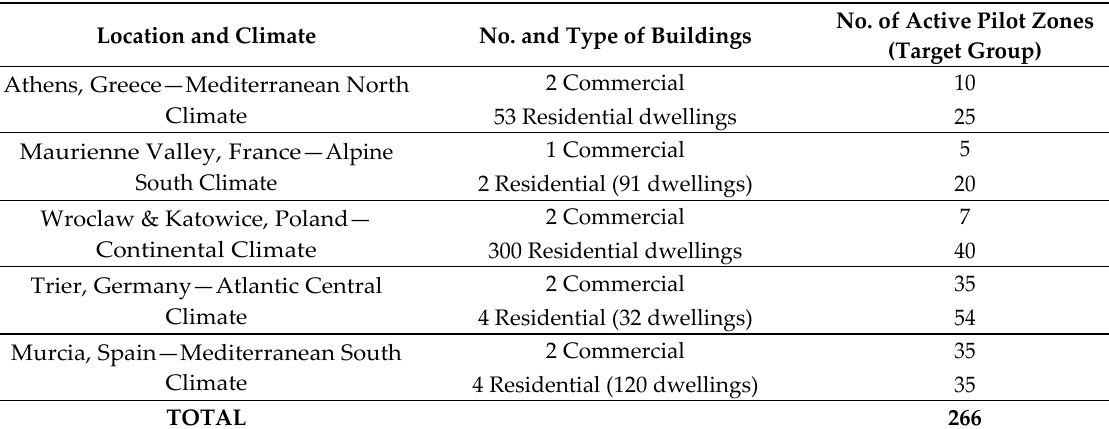
Table 2. UtlitEE Pilot sites characteristics across